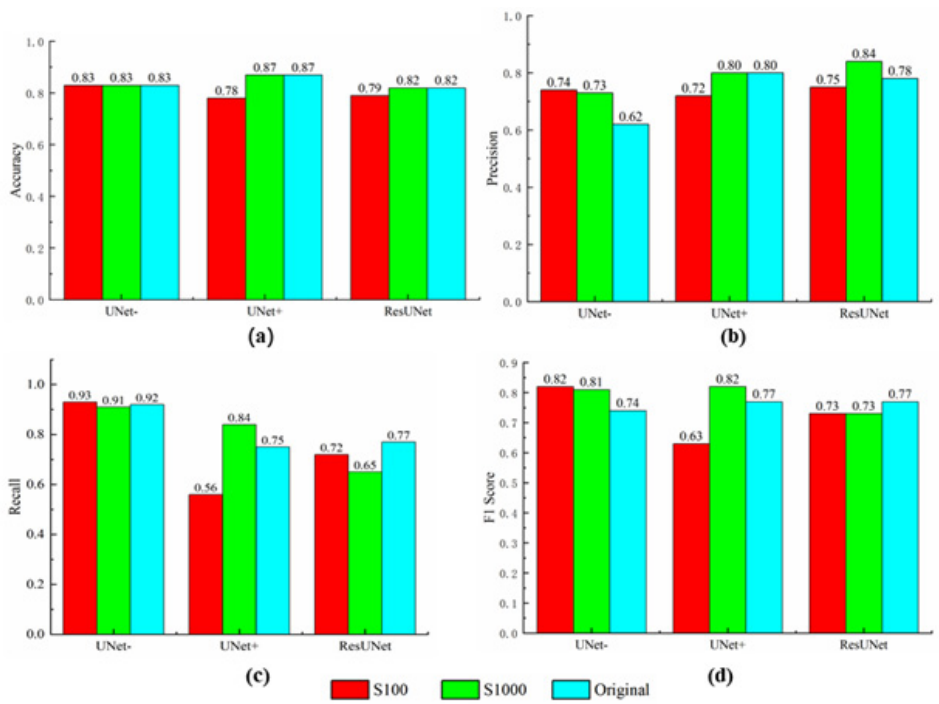
Figure 10. Statistical performance of the UNet, UNet+, and ResUNet models: ( a ) accuracy; ( b ) precision; ( c ) recall; ( d ) F1 score.